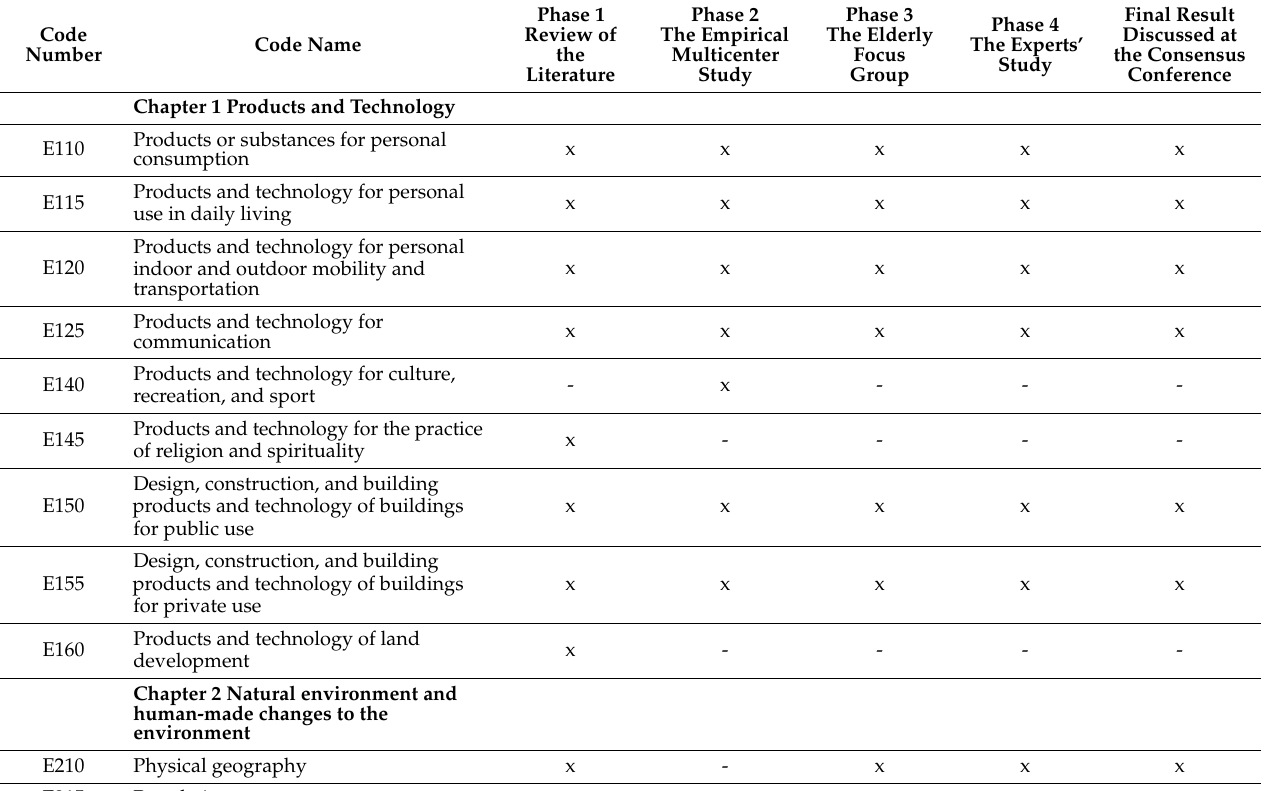
Table 2. Selection of codes in the first four phases of the